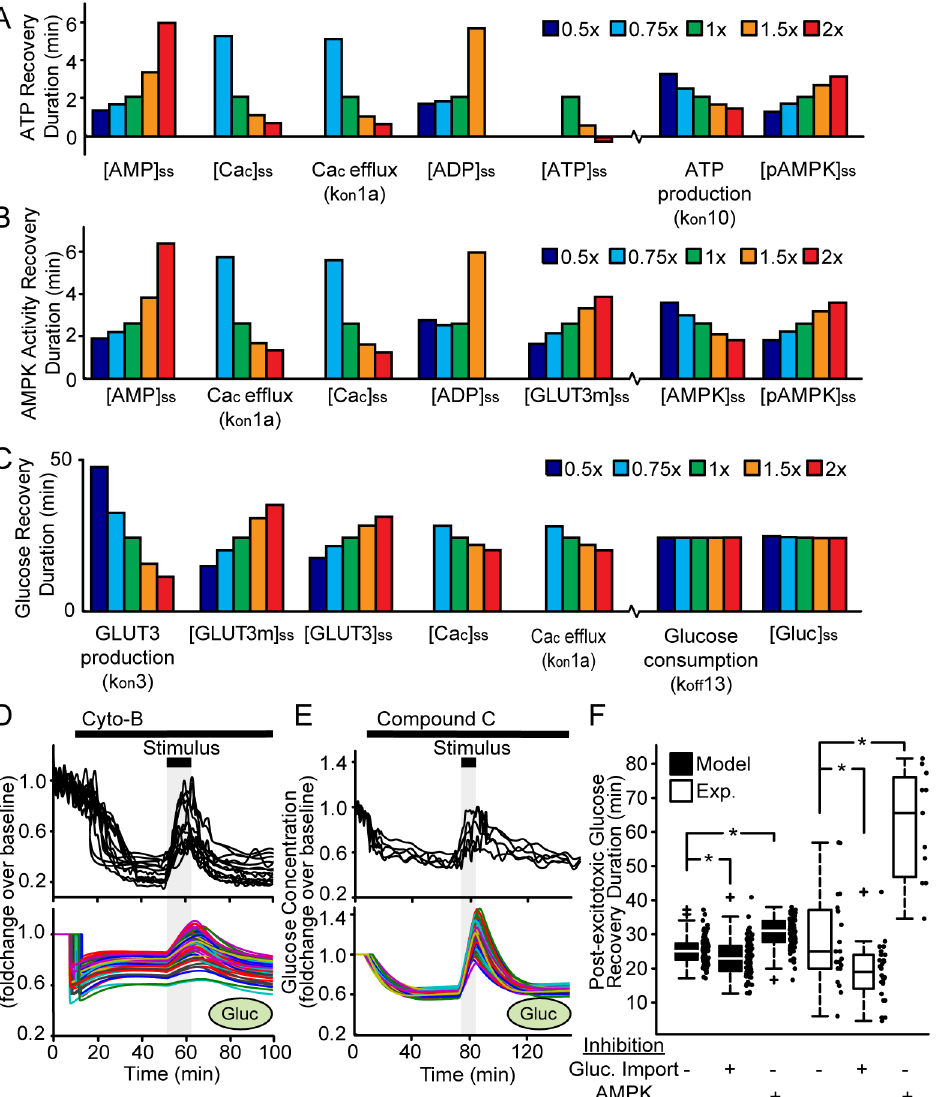
Fig 3. Sensitivity analysis indicated that glucose import dynamics are critical to the post-excitotoxic glucose recovery. (A-C) Parameters were varied by 0.5 (navy), 0.75 (light blue), 1 (green), 1.5 (orange) and 2 (red) times the steady-state values listed in Tables 1 and 2, and the effect was calculated for the post-excitotoxic recovery duration of the (A) ATP, (B) AMPK activity and (C) Glucose signals. The varied parameter is written under each bar chart. The 5 parameters with the greatest effect on each metric are shown (left to right in order of effect), along with other parameters mentioned in the text. Data were omitted for parameter values at which the modelled state variables did not return to baseline within the simulation time (100 min). (D, E) Experimental traces (top panels) and multiple model simulations (bottom panels) of intracellular glucose concentration with either (D) glucose import or (E) AMPK inhibited prior to exposure to a transient excitotoxic stimulus. (D) Glucose import was inhibited by exposure to Cytochalasin B or by reduction of the modelled glucose import kinetics (Rx 9). (E) AMPK activity was inhibited by exposure to Compound C or by reduction of the modelled AMPK phosphorylation kinetics (Rx 6). Compound C experiments have been published previously [Fig 6A from [15]]. (F) Box- and scatter-plots of the glucose recovery duration with and without glucose import or AMPK inhibition ( * ranksum p <